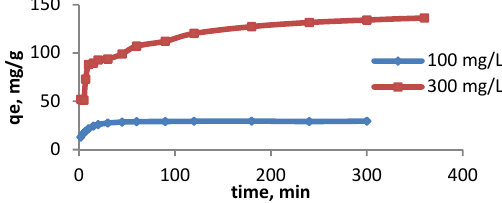
Fig.7. Effect of time on dye uptake of MB on AC prepared by